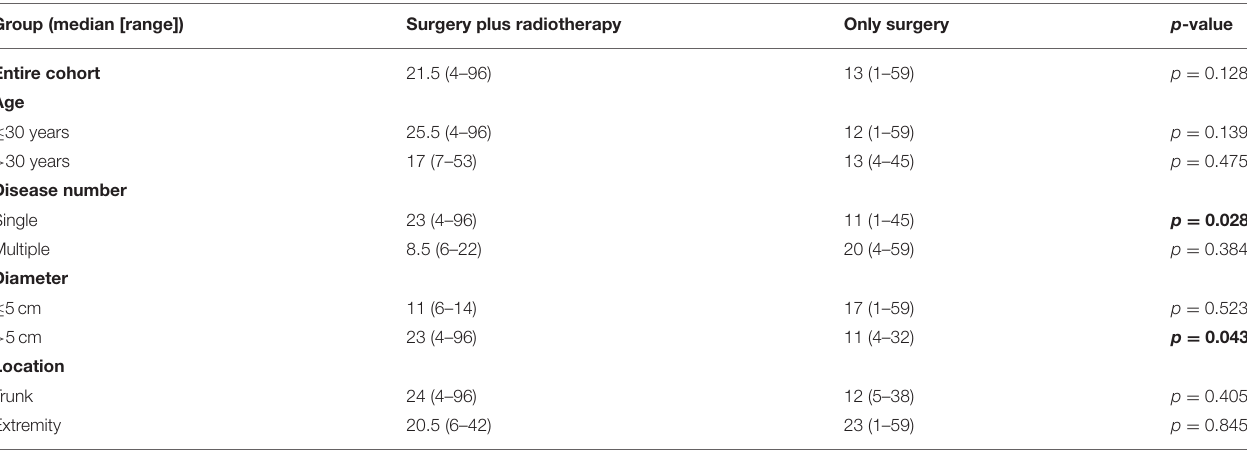
TABLE 3 | TTR comparison between surgery plus radiotherapy and only